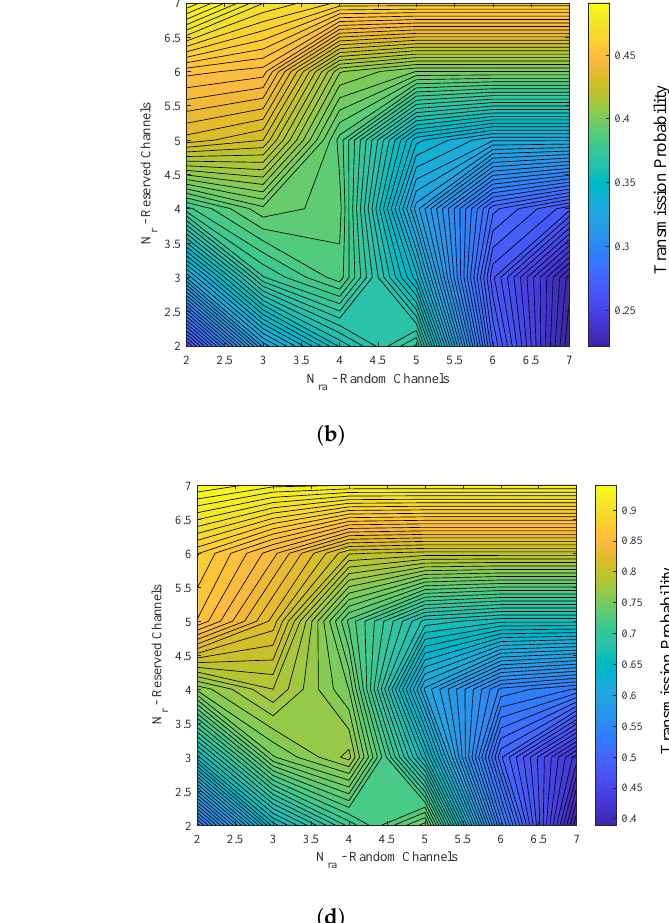
Figure 3. Relationship between N a random channels and N r reserved channels. ( a ) Scenario with 300 smart meters; ( b ) scenario with 250 smart meters; ( c ) scenario with 200 smart meters; ( d ) scenario with 150 smart